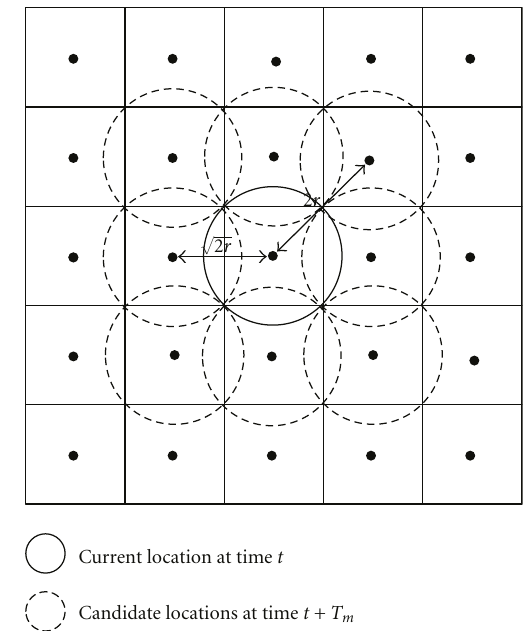
Figure 3: A mobile node’s candidate locations at a given